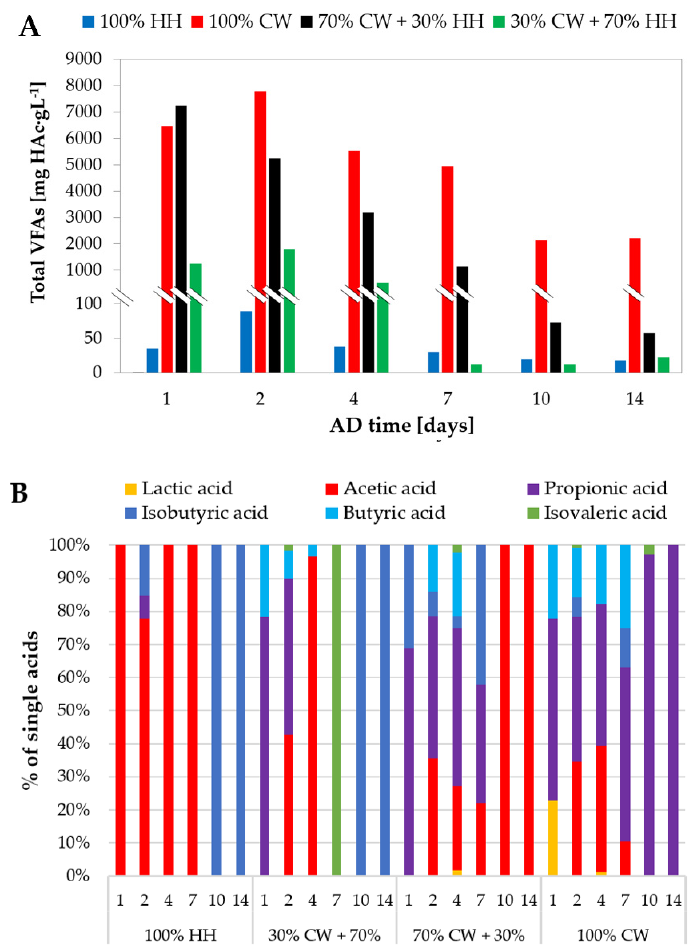
Figure 2. ( A ) Concentration of total volatile fatty acids (VFAs) as intermediates of anaerobic digestion (AD) of standalone cheese whey (CW) and hemp hurds (HH) as well as of co ‐ digestion (coAD) of 70% CW + 30% HH and 30% CW + 70% HH. ( B ) Percentage of lactic acid and each VFA over the total acid concentration (calculated on an equivalent acetic acid basis) during the initial 14 days of AD and coAD.